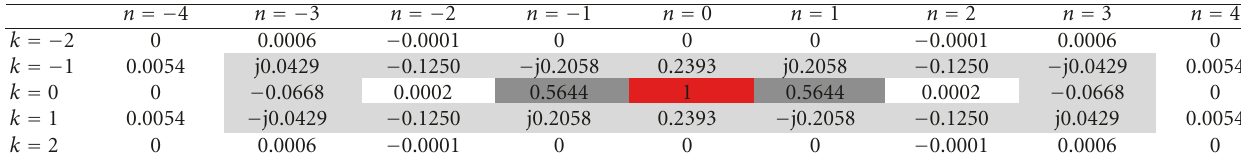
Table 1: Interference weights for data surrounding the symbol in the center of the